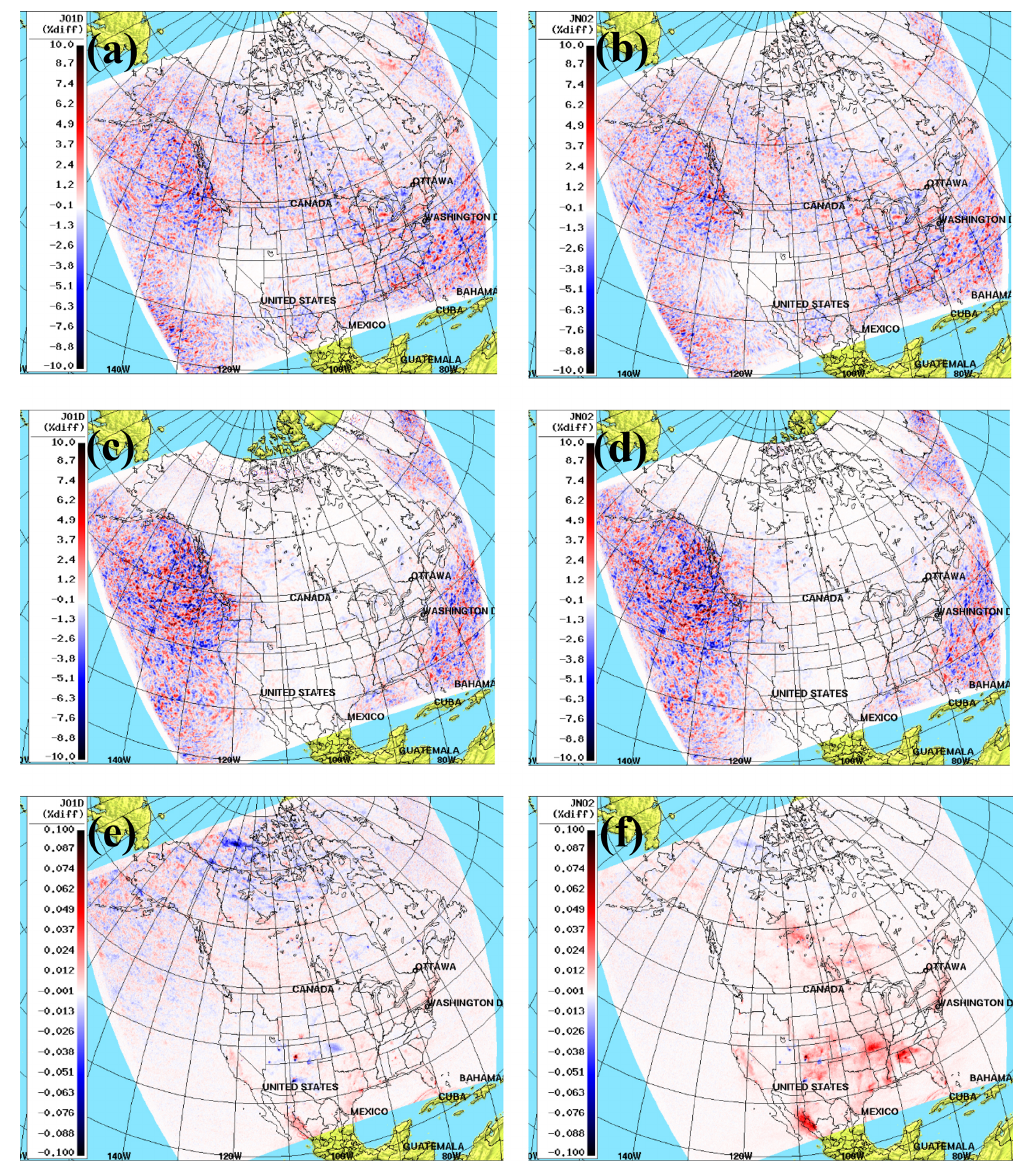
(cid:16) J (cid:17) × 100 AOD − J no-AOD Figure 10. Percentage difference in daytime monthly averaged photolysis rates ( J (O 1 D) and J (NO 2 ) ) at the (J AOD + J no-AOD )/ 2 lowest model level, with and without AOD calculations. (a, b) June 2018 with online interactive aerosol feedback. (c, d) January 2018 with online interactive aerosol feedback. (e, f) June 2018 without online interactive aerosol